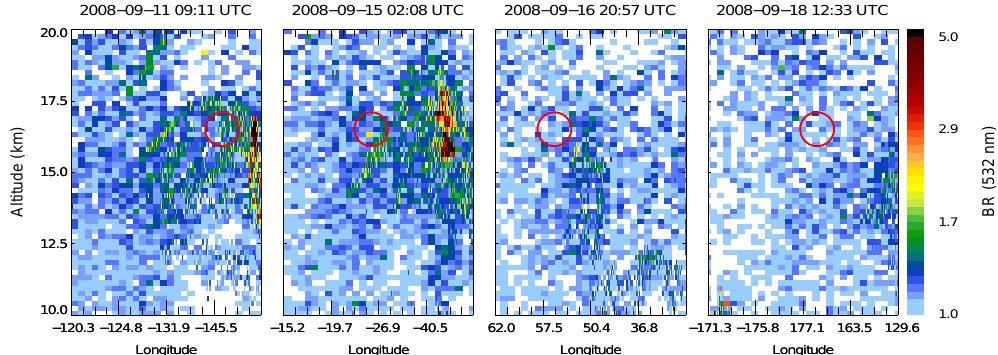
Figure 4. CALIOP backscatter ratio (color coded) vs. altitude and longitude. Red circles highlight the intersection with the 400K isentropic trajectory.